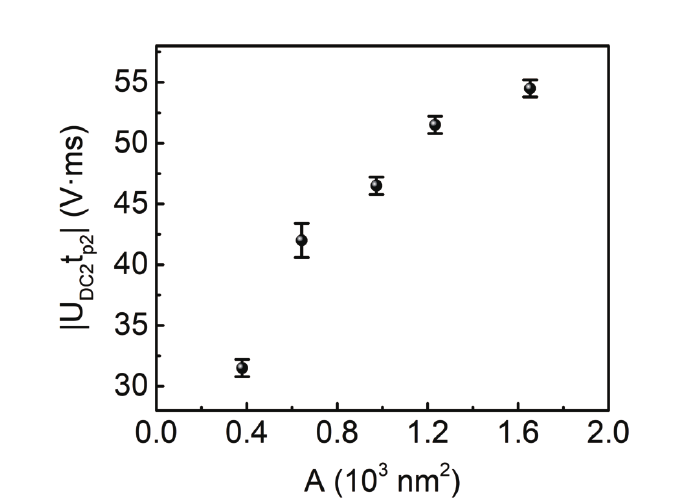
(cid:12) (cid:12) (cid:12) U DC 2 t p 2 (cid:12) on the inner domain area A